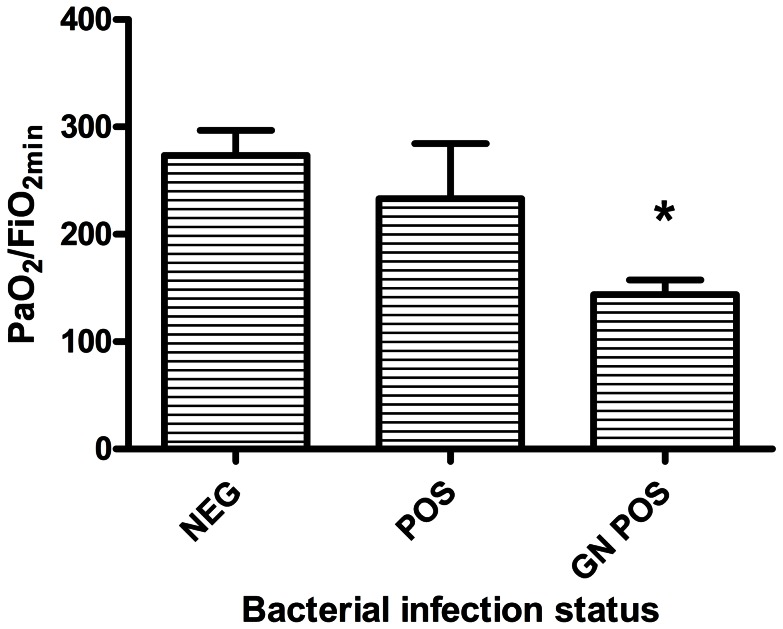
Comparison of the lowest PaO2/FiO2 ratios during the first 2 weeks post injury (PaO2/FiO2) among patients with no bacterial pathogens isolated from respiratory secretions during the first 2 weeks (NEG), patients with bacterial pathogens of any type (POS), and patients with gram negative bacteria (GN POS).Patients in whom no bacterial cultures were collected are not included in this analysis. * = P<.05 vs. NEG.